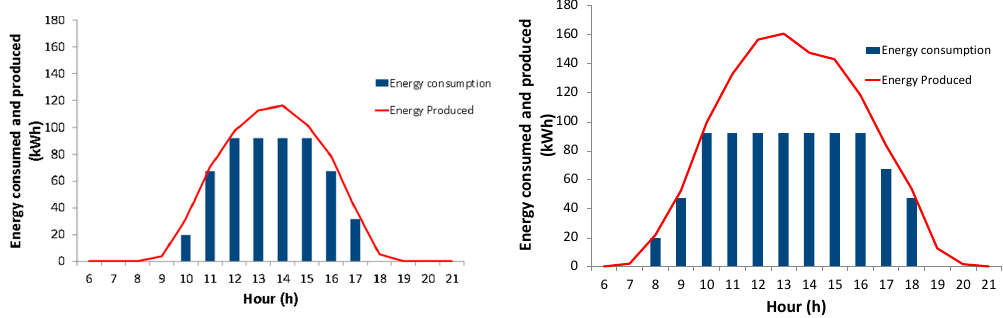
Figure 5. The energy produced and consumed in January ( left ) and in April ( right ).